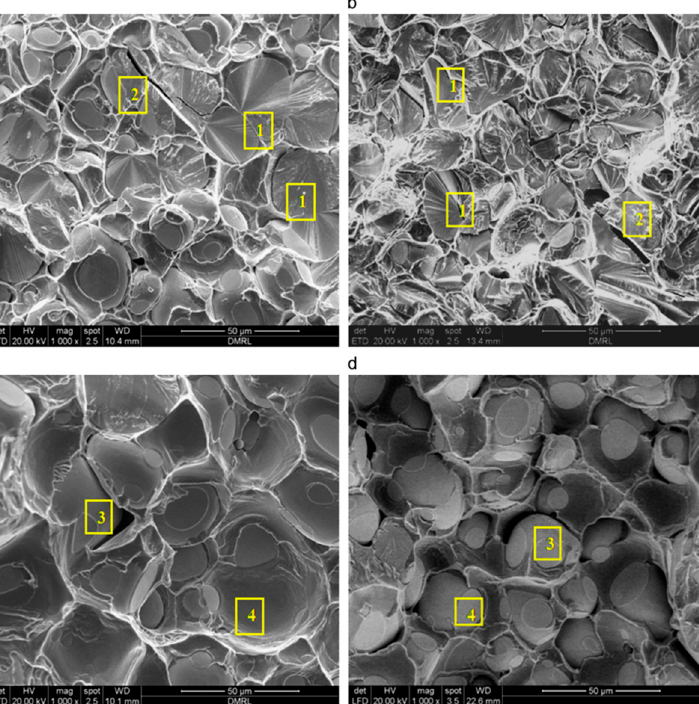
Figure 20. Fractography images ( a ) 90W–3Fe–7Ni (MW-sintered), ( b ) 90W–2Fe–6Ni–2Co (MW-sin- tered), ( c ) 90W–3Fe–7Ni (conventionally sintered), ( d ) 90W–2Fe–6Ni–2Co (conventionally